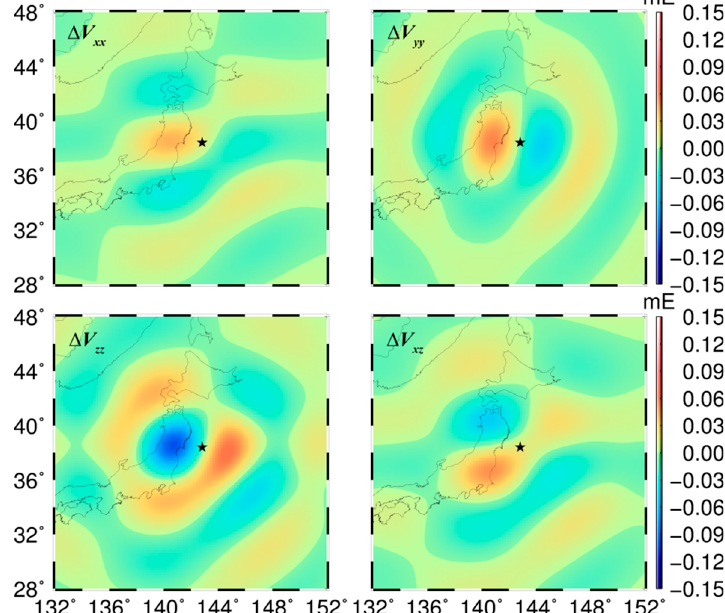
Figure 6. Gravity gradient changes ( Δ V xx , Δ V yy , Δ V zz , and Δ V xz ) in Local North-Oriented Frame on a sphere with a height of 260 km computed by the tailored spherical harmonic coefficients from the forward-modeled coseismic signals with a Gaussian filter applied. The SH degree range is 30–95 and the radius of the filter is 210 km. The units are mE.